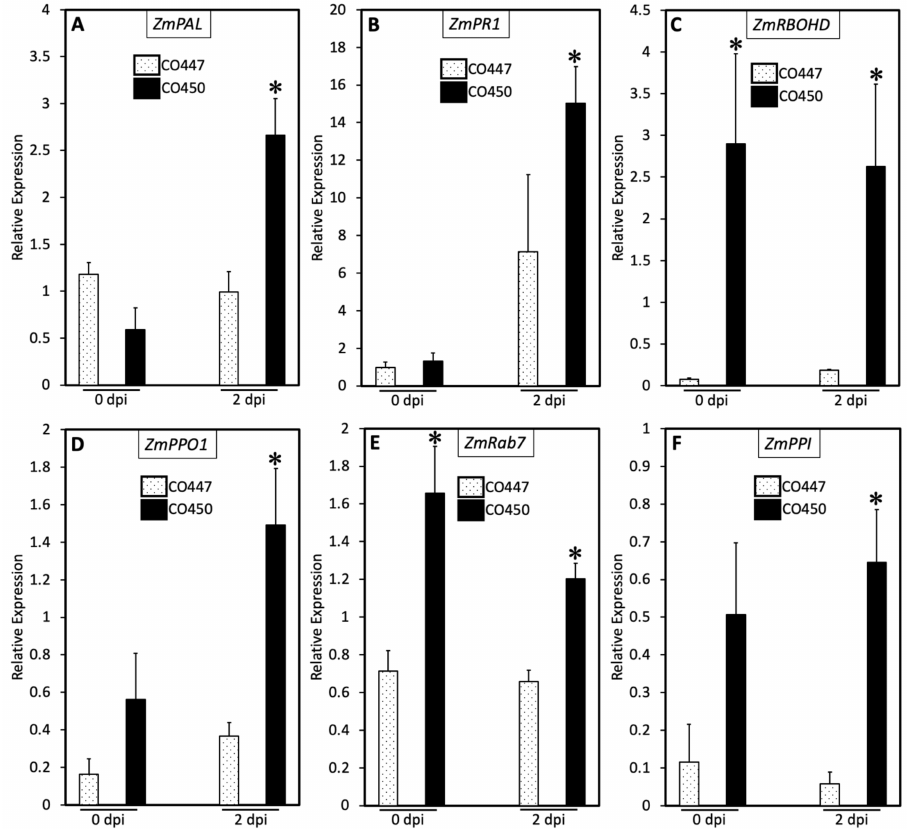
Figure 3. SA and PCD regulate disease resistance in corn plants in response to C. nebraskensis. Real time RT–qPCR analysis showing the transcript levels of the SA-regulated genes ZmPAL ( A ), ZmPR-1 ( B ), and the PCD marker genes ZmRBOHD ( C ), ZmPPO1 ( D ), ZmRab7 ( E ), and ZmPPI ( F ) in response to CMN14-5-1 of the CO447 and CO450 corn lines measured. Leaves were sampled at 0 h and 48 h after treatments. Reference gene was the Elongation Factor 1 ( EF1a ). The results are representative of three biological replicates. The error bars represent the standard error. Asterisks denote significant differences, * p <